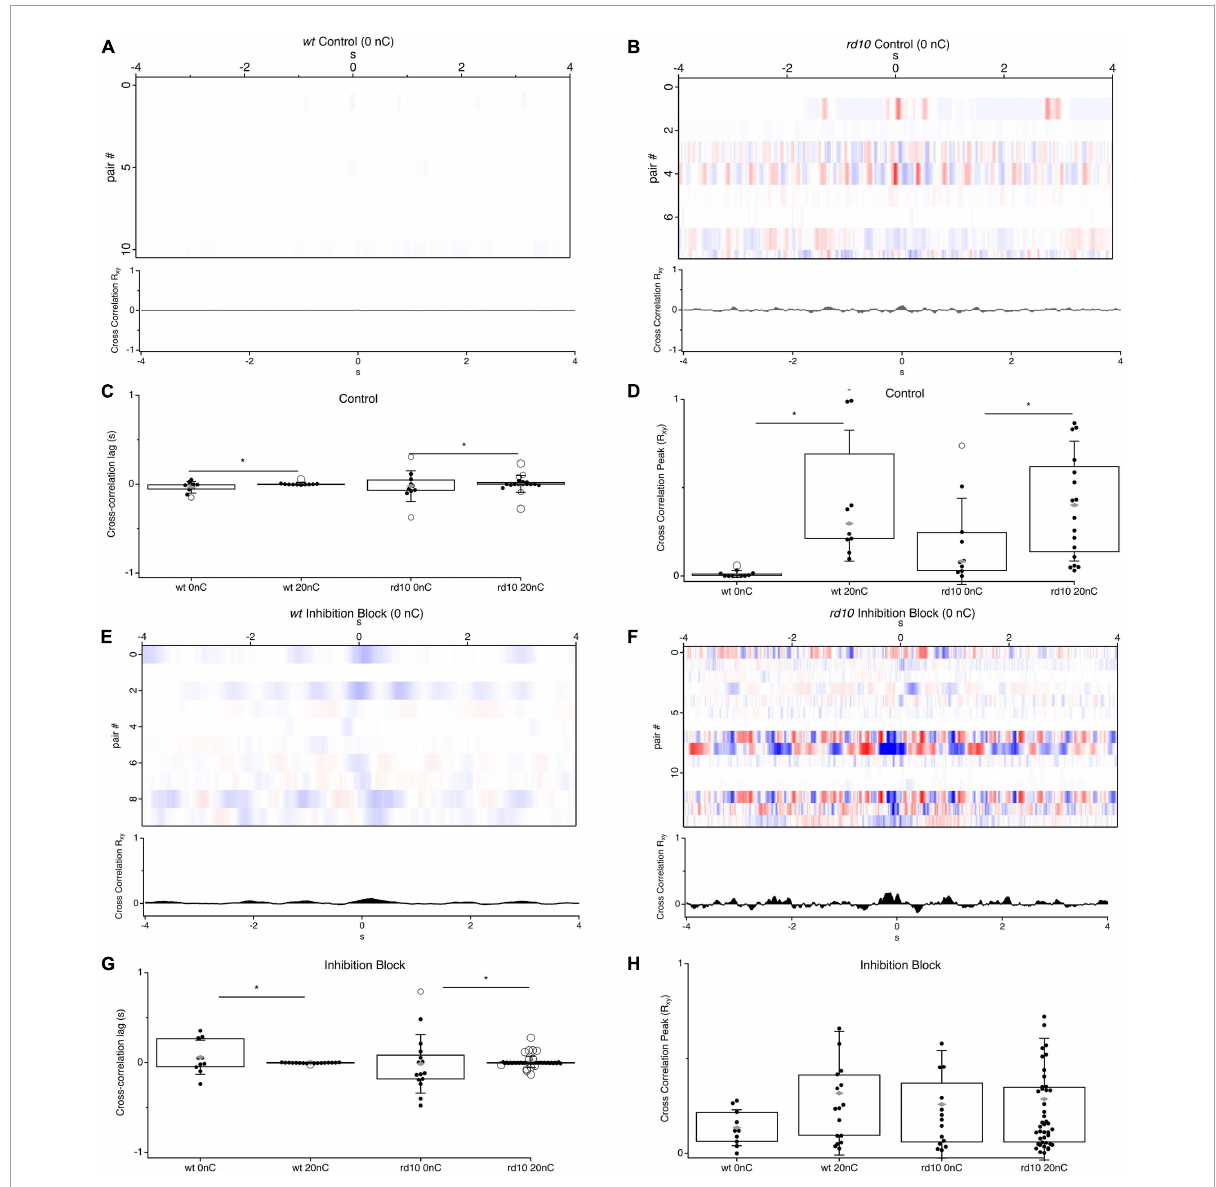
FIGURE3 Comparison of cross-correlation between RGC pairs for stimulation and no stimulation conditions. (A) Heatmaps of cross-correlations between RGC pairs for wt control conditions ( n = 11) and (B) rd10 ( n = 10) during no stimulation. (C) Box plots for comparison of times of cross-correlation peaks for wt and rd10 RGC pairs at 20 nC and 0 nC. (D) Box plots for cross-correlation peak magnitude. (E,F) Heatmaps of cross-correlations between RGC pairs for wt ( n = 10) and rd10 ( n = 15) during inhibition block (5- µ M SR 95531, 50 µ M TPMPA, and 5 µ M strychnine). (G,H) Same as panels (C,D) , but during inhibition block. For box plots, filled black circles represent data points, open circles represent outliers, whiskers show 1 standard deviation, gray diamonds represent the mean. *Denotes p < 0.05. Traces below each heatmap